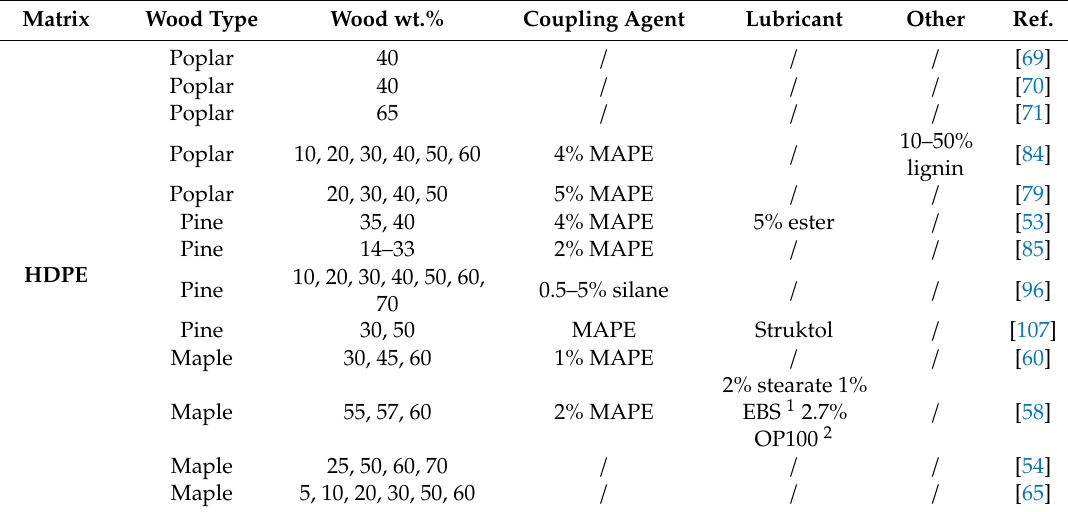
Table 5. Formulations tested with rotational